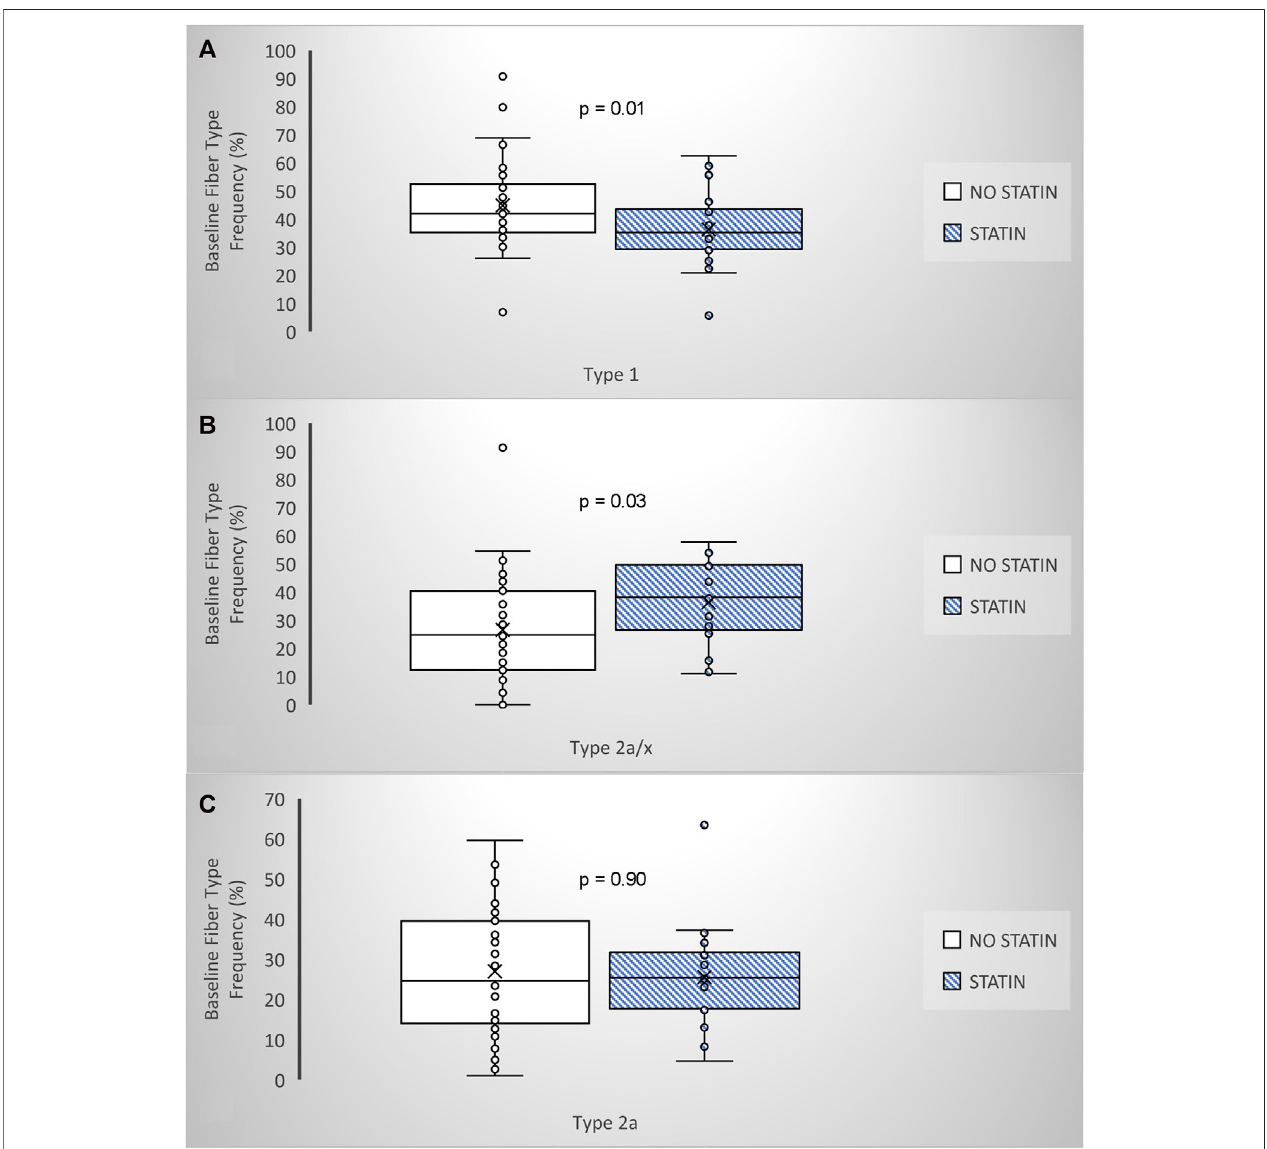
FIGURE1| Statintherapyand fi ber typefrenquency priortoPRTamoung adultsBOXandwhiskerplotsshowthatthosetakingstatins( n =25)have (A) lowertype 1, (B) higher 2a/x hybrid and (C) no difference in type 2a fi ber frequency when compared to those not on a ststin (n-43). ANCOVA, adjusted for sexand physical activity. p -values are